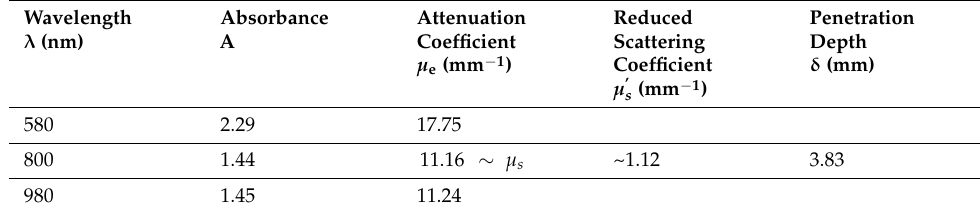
Table 1. Absorbance and attenuation coefficient of the gray matter in the cerebral cortex of a human